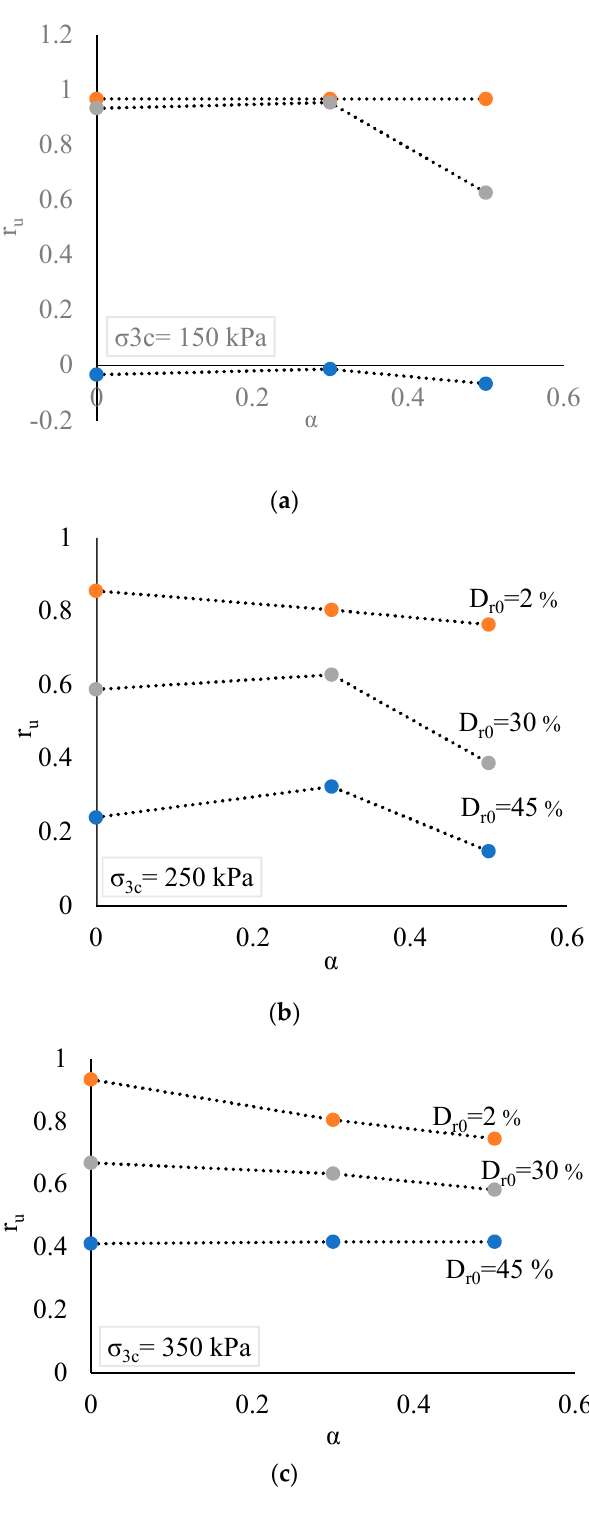
Figure 15. Pore water pressure ratio versus initial shear stress ratio at ( a ) 159 kPa, ( b ) 250 kPa and ( c ) 350 kPa effective confining pressure.